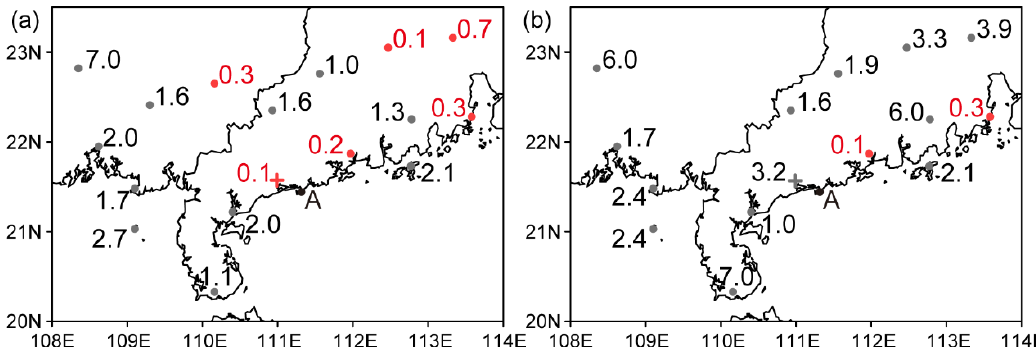
Figure 4. Fog and light-fog visibilities (km) at various inland and coastal stations during the two sea-fog periods. ( a ) Case 1. ( b ) Case 2. The “ + ” is inland site C (DNCO). Red denotes fog; black is light fog.